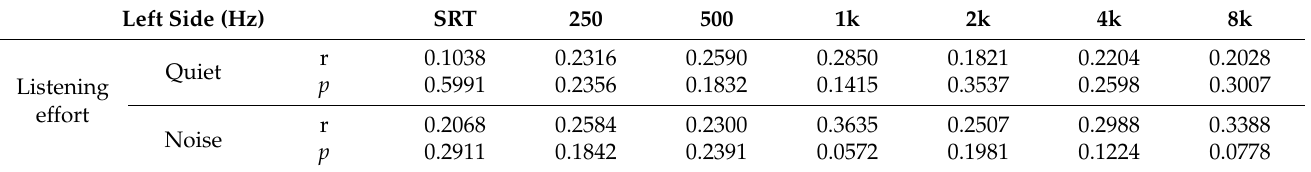
Table A2. Correlation analysis of Listening effort and SRT/PTA frequencies in left